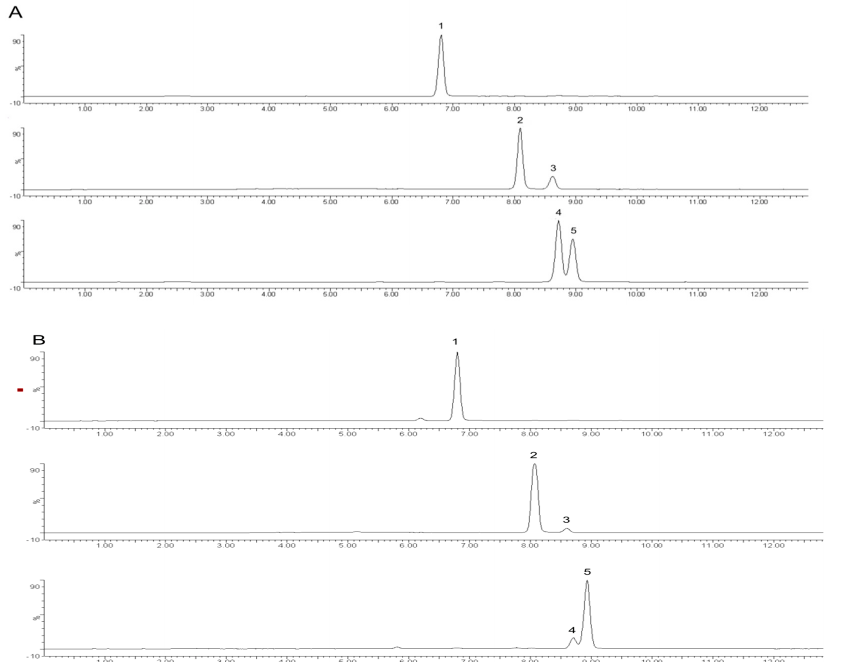
Table 1. Monosaccharide Composition and Molar Ratio of PPL-1.